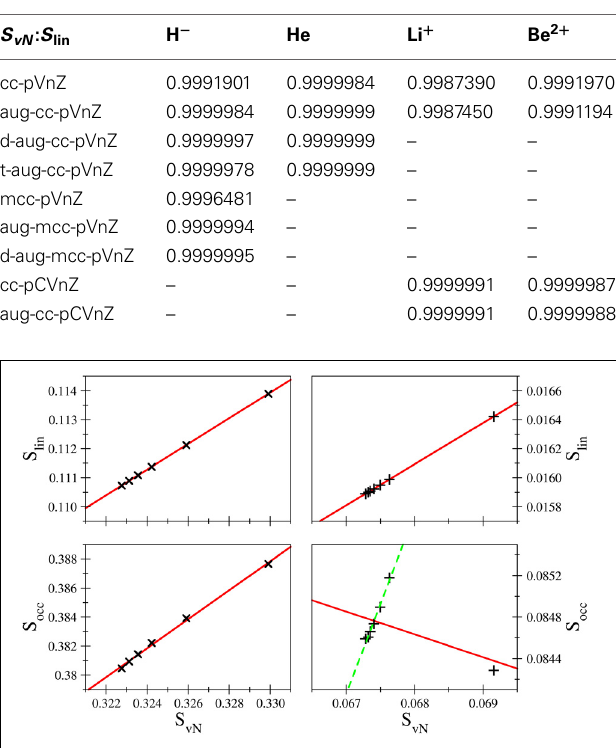
Table 2 | Correlation coefficients R resulting from linear regression of the von Neumann and linear entropies.